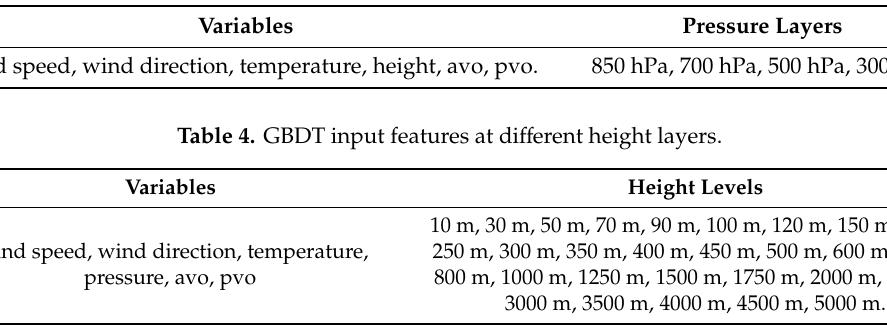
Table 3. GBDT input features at di ff erent pressure layers.